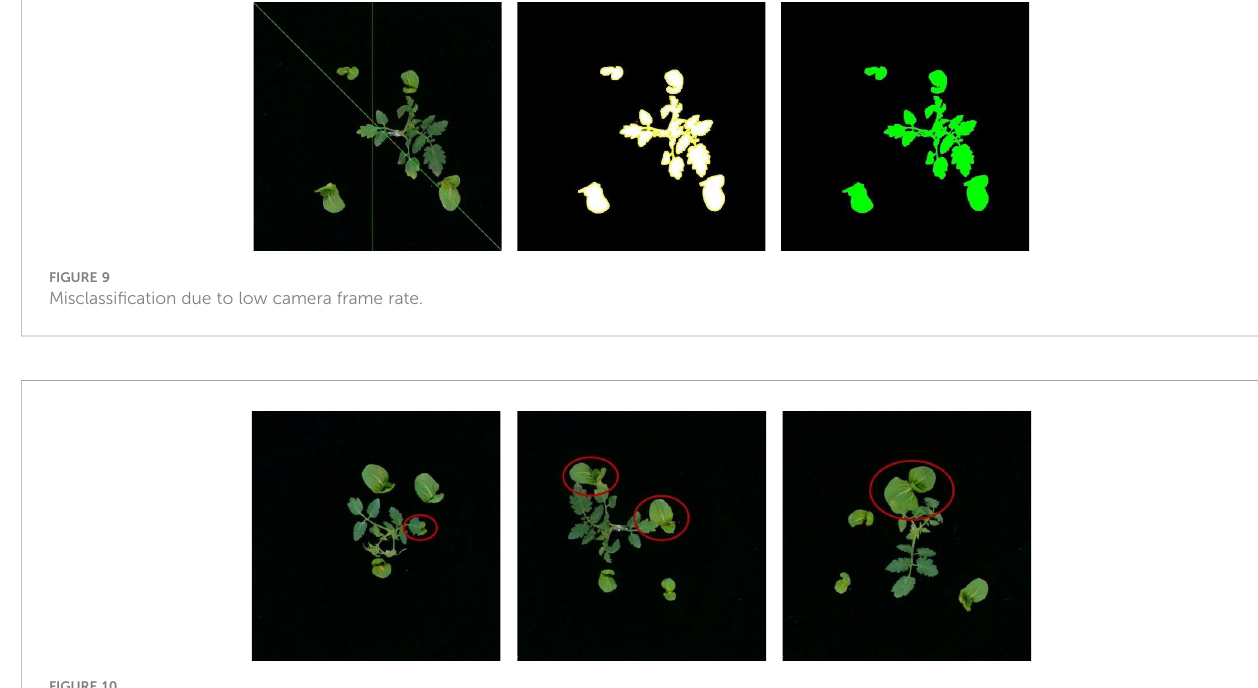
FIGURE 10 Weeds too close to tomato plants (red circles).